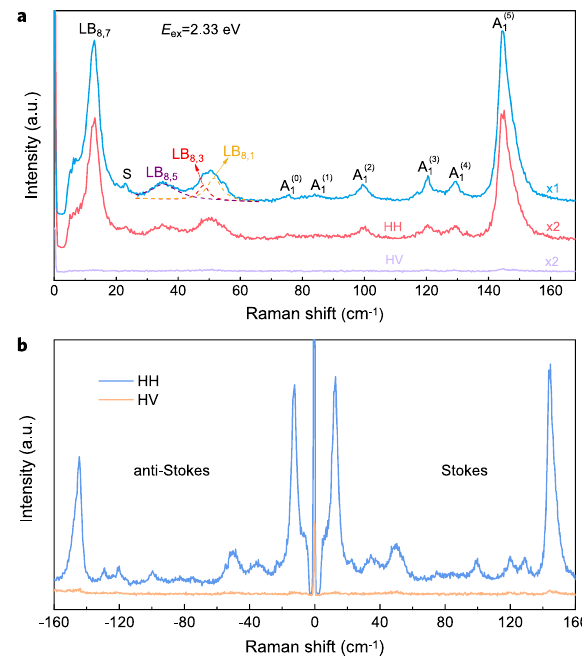
Fig. 5 Ultralow-frequency Raman spectroscopy of PdSe 2 . a Raman spectra of under unpolarized, parallel (HH), and cross (HV) polarization con fi gurations. b Stokes/anti-Stokes Raman spectra measured in HH and HV polarization con fi